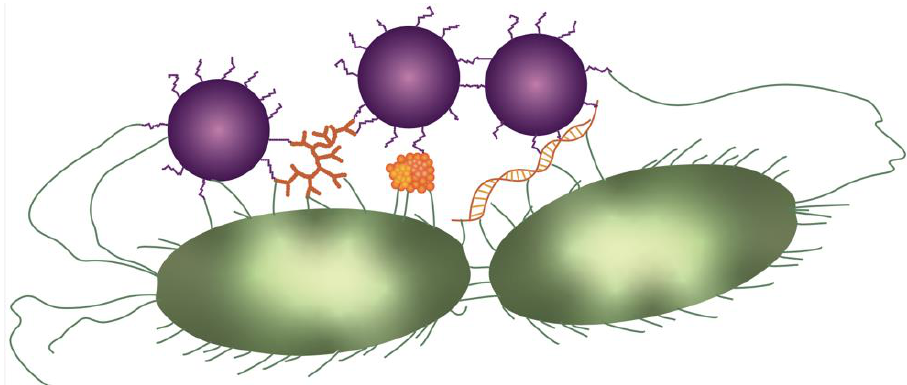
Figure 2. Coaggregation. During coaggregation, genetically distinct bacteria (here depicted in purple and green) can form aggregates by physically binding to each other through specific molecules, including exopolysaccharides, proteins and eDNA (depicted in orange). The physical interaction is facilitated by cellular appendages including pili, flagella and fimbriae, as well as extracellular molecules.